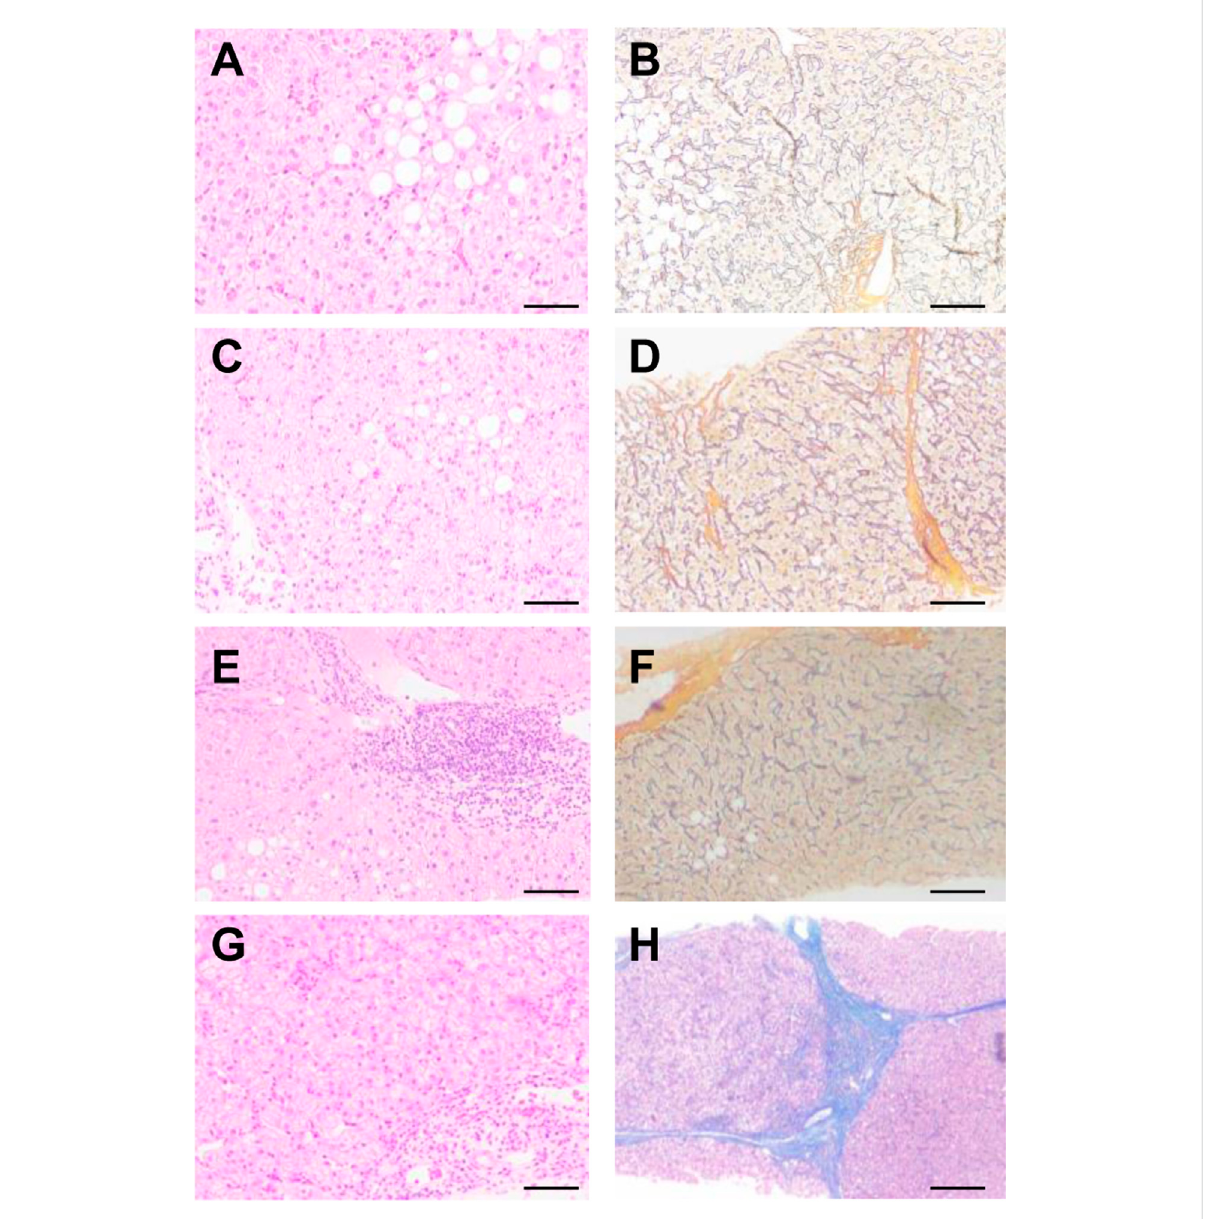
comparisons of normally distributed data. Single-factor analysis of variance was used for multigroup comparisons. Spearman correlation analysis was used to analyze correlations between various factors and the occurrence and degree of liver fi brosis in patients with